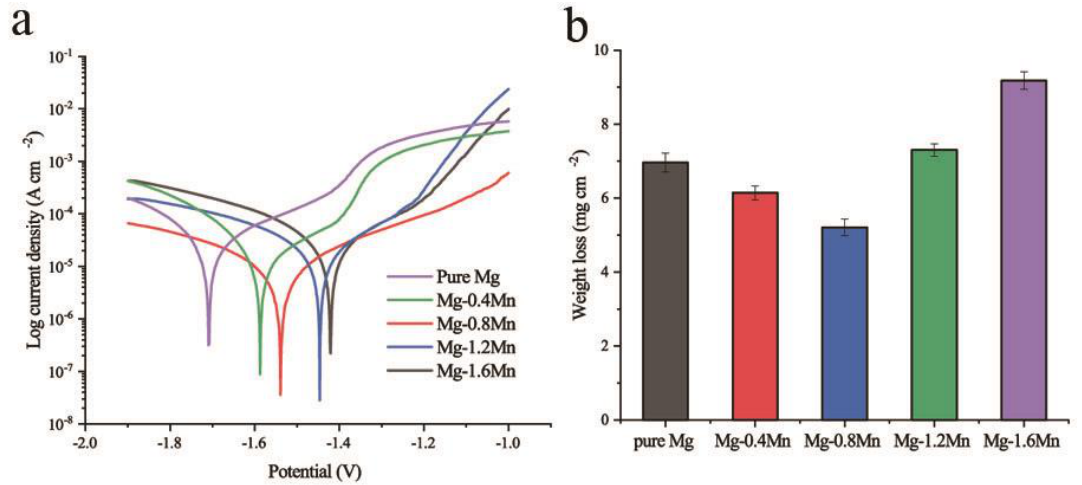
Table 2. The i corr value of the SLMed Mg was 29 µ A / cm 2 . Alloying Mn into Mg by SLM first decreased